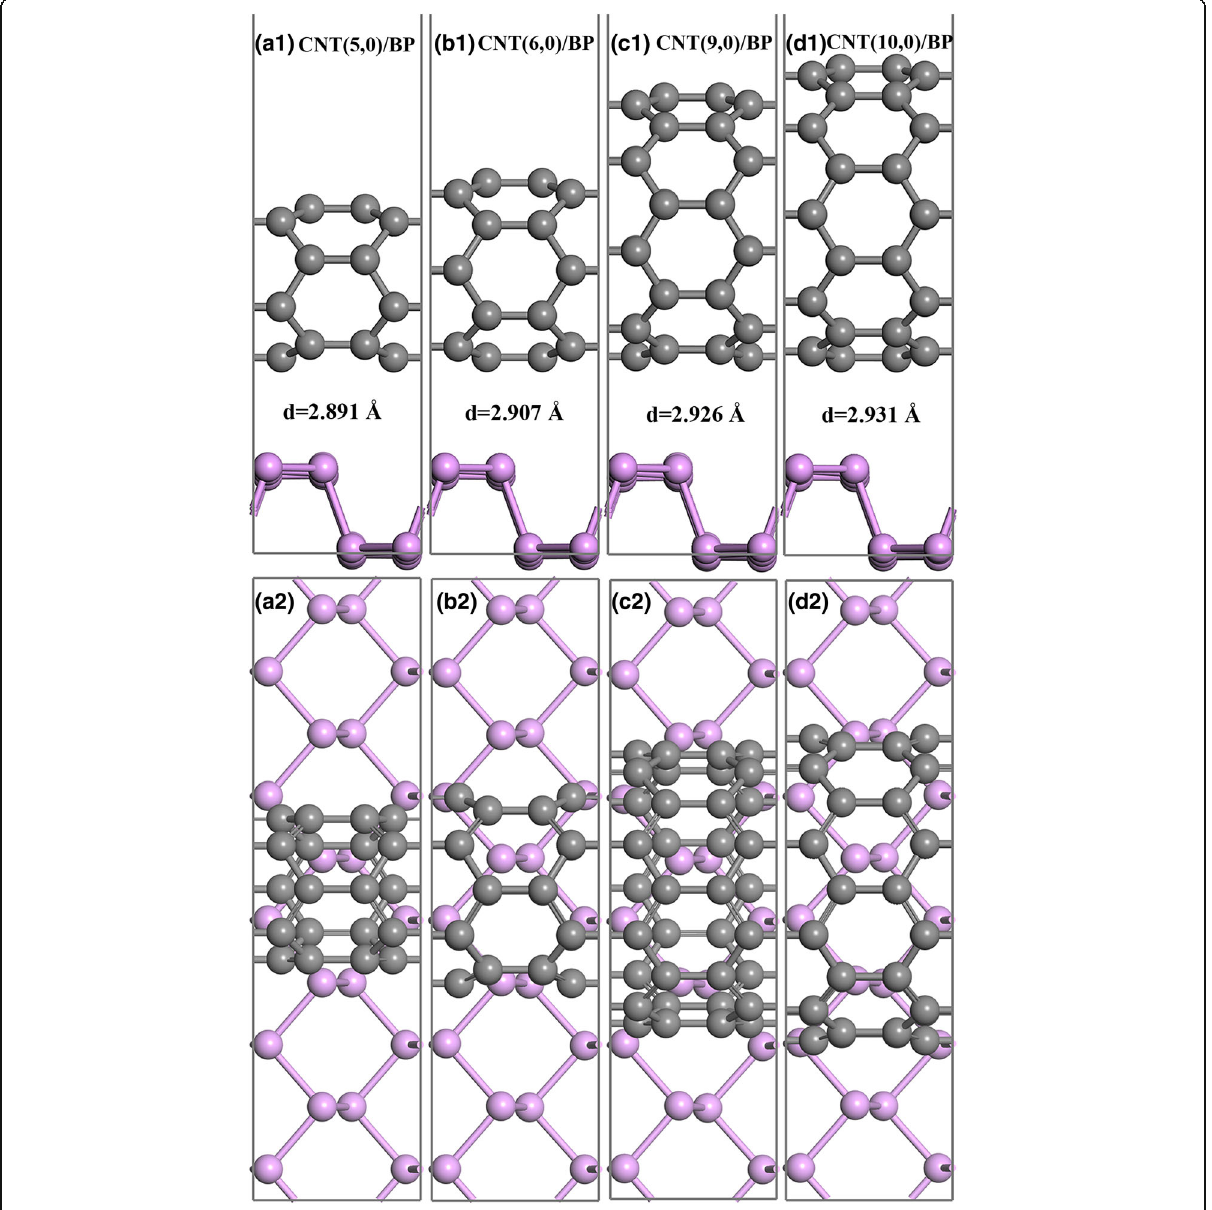
Fig. 1 The optimized geometry for different CNTs on monolayer BP: a1 – d1 and a2 – d2 are side and top view for (5, 0), (6, 0), (9, 0), and (10, 0) CNTs, respectively. The equilibrium spacing between the nanotube wall and the top P atom layer is denoted by d . Gray and pink spheres represent C and P atoms,